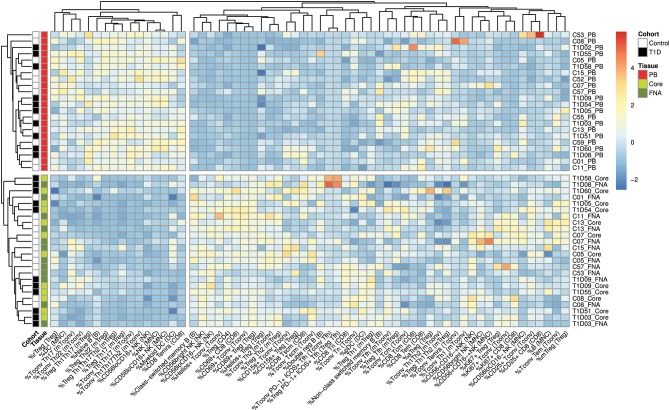
Cells from blood and iLN biopsies display distinct immune profiles. Unbiased Hierarchical clustered heatmap analysis of cell population frequencies (n = 61) in peripheral blood (PB), fine needle aspirates (FNA), and core biopsies (Core) from all control and T1D subjects (n = 12 and n = 10, respectively). The frequency of each population was normalized to the mean frequency from all subjects and tissues and values represent the fold change from mean for each individual sample. Control subjects or those with T1D are indicated with white and black symbols, respectively. Samples from PB, Core and FNA biopsies are depicted by red, light green and dark green symbols, respectively. Individual sample identifiers are shown on the right of the plot indicating cohort group, subject number and biopsy type. Tn, naïve T cells; Tcm, central memory T cells; Tem, effector memory T cells; Temra, Terminally differentiated T cells; Tscm, stem-cell memory-like T cells; rTreg, resting Treg; mTreg, memory Treg; aTreg, activated Treg; Tfh, follicular helper cells; MNC, mononuclear cells; NK, natural killer cells; DC, dendritic cells. Frequencies of cell populations were derived from the cell subset indicated in parentheses.